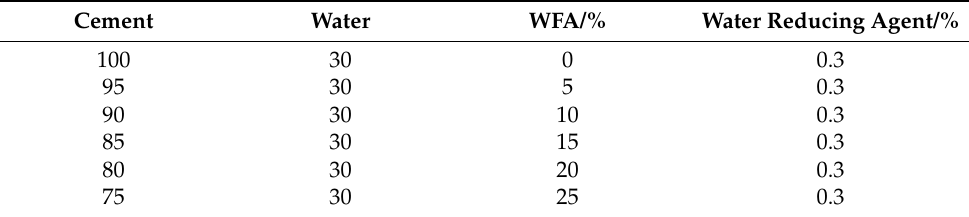
Figure 5. The AC electrical resistance of cement paste with different dosages of waste fly ash.